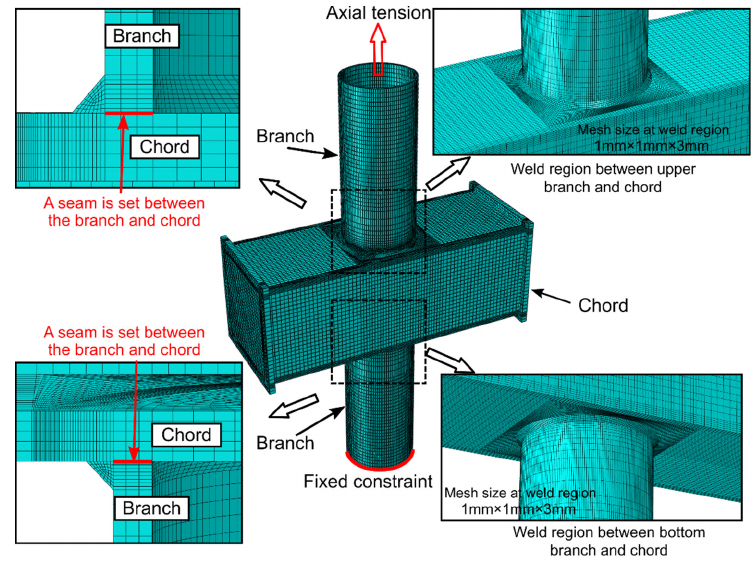
Figure 12. Finite element model of the X90-2 joint specimen.